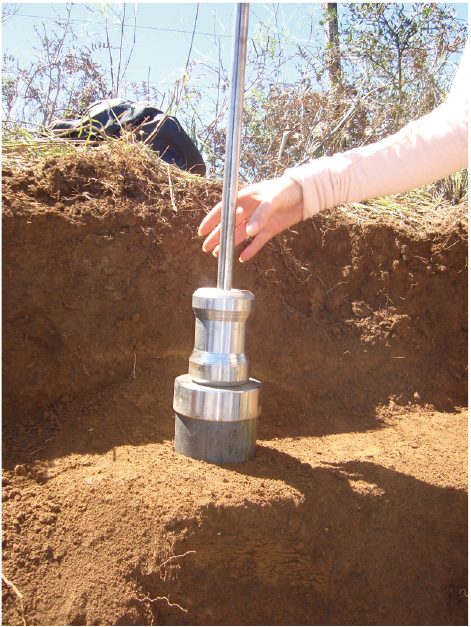
Figure 2. Volumetric rings with soil mass shrunk and after filling with sand (Ring with Sand